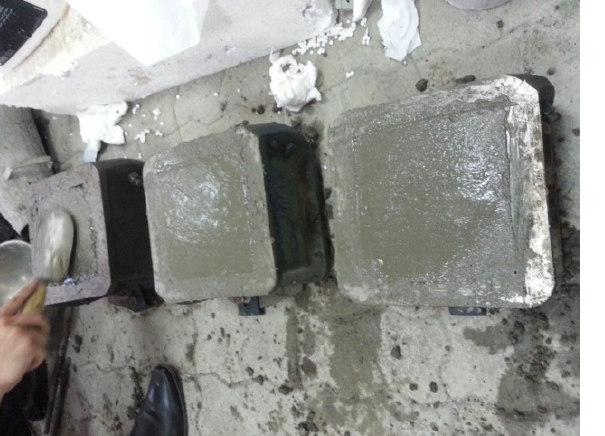
Figure 2: Cube casting.